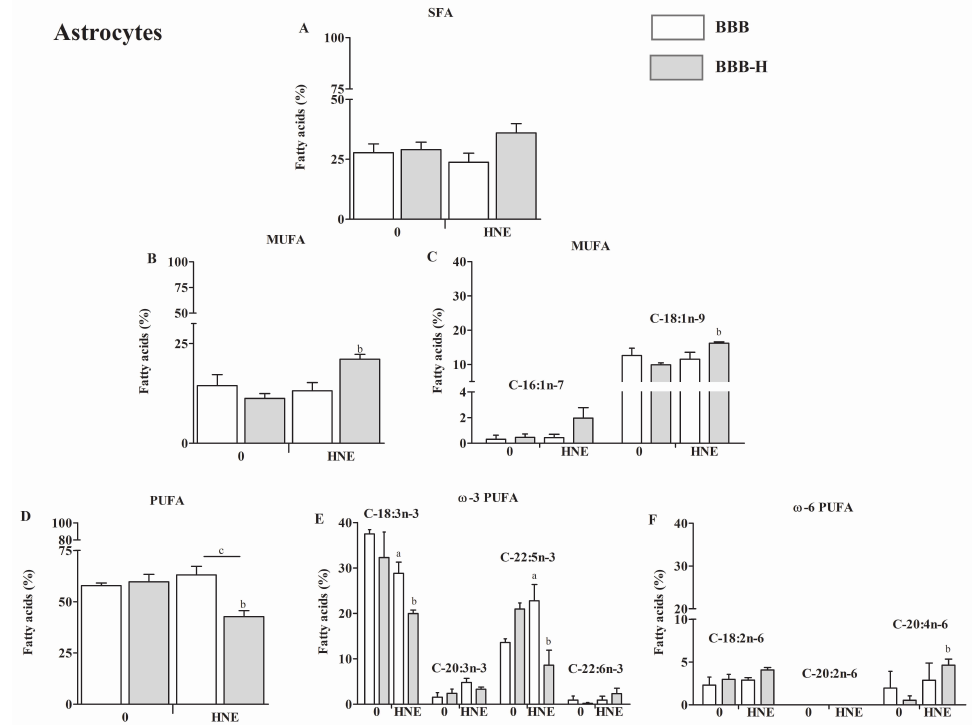
Figure 6. Fatty acid composition of astrocytes of BBB and BBB-H model at control conditions (0) and 20 µ M HNE treatment based on the degree of saturation: saturated fatty acids (SFA) composition ( A ); monounsaturated fatty acids (MUFA) composition with major representatives ( B , C ); polyunsaturated fatty acids (PUFA) composition with major ω 3 and ω 6 representatives ( D – F ). All results are repre- sented as mean ± SEM, n = 4 samples for each group from 2 independent experiments. a—statistically significant in respect to control (0) on pure collagen, p < 0.05; b—statistically significant in respect to control (0) on modified collagen, p < 0.01; c—statistically significant between groups of same treatment, p <